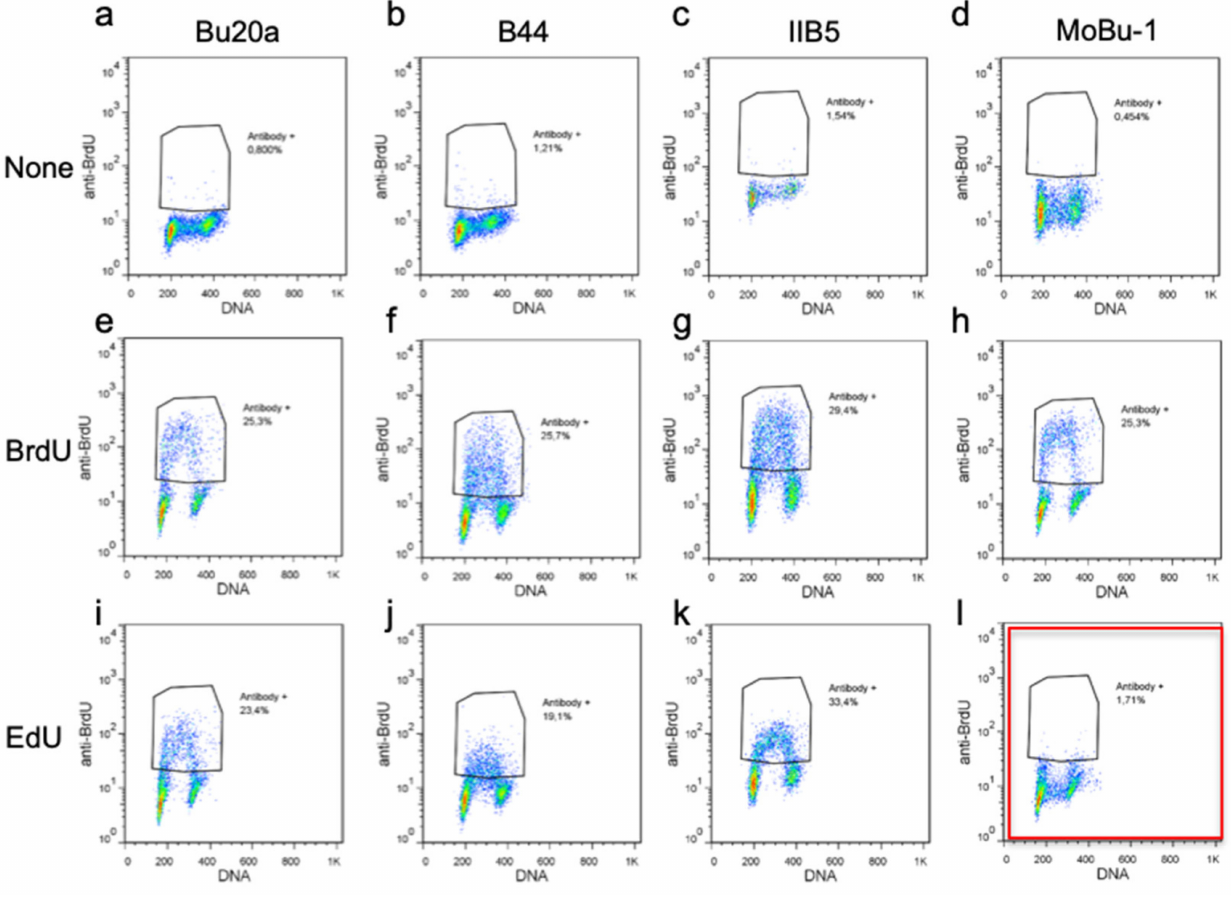
Figure 2. Selection of a BrdU antibody not recognizing EdU. Unlike the Bu20A ( a , e , i ), B44 ( b , f , j ) and IIB5 ( c , g , k ) anti-BrdU antibodies, clone MoBU-1 ( d , h , l ) does not cross-react with EdU-substituted DNA. MEF cells were left untreated (top row), treated with BrdU (middle row), or with EdU (bottom row), then stained with the various BrdU antibodies and detected by flow